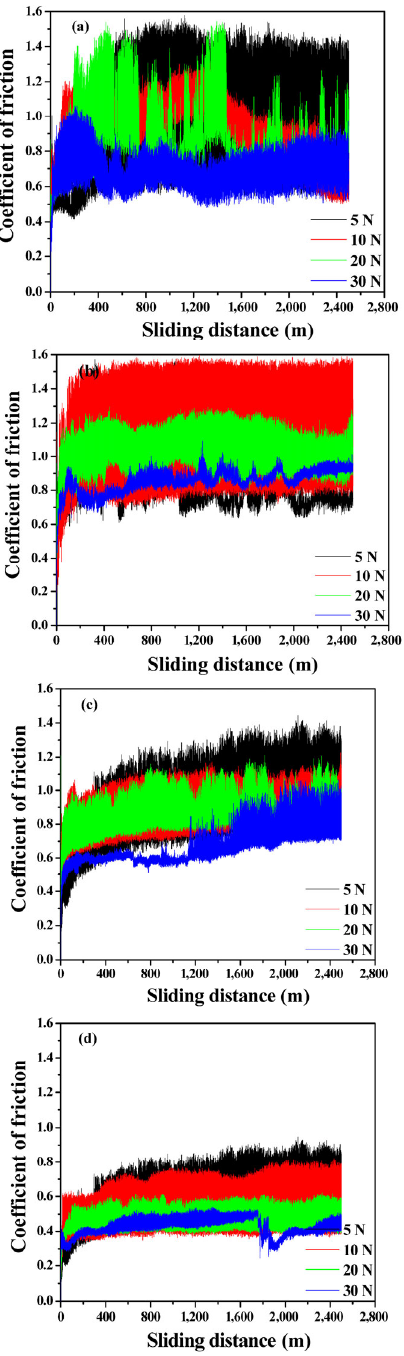
Fig. 7 Variation of COF under different applied loads and sliding distances of 2,500 of (a) as-cast, (b) cold compacted, (c) sintered, and (d) HPTed Cu